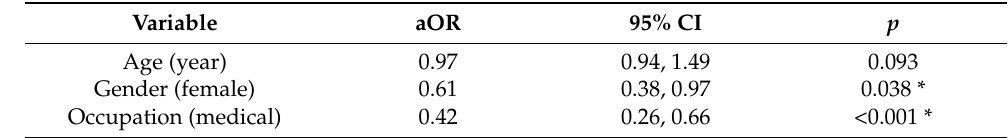
Table 6. Results of ordinal logistic regression for the factors associated with the number of reported side-effects following COVID-19 vaccine ( n = 250).